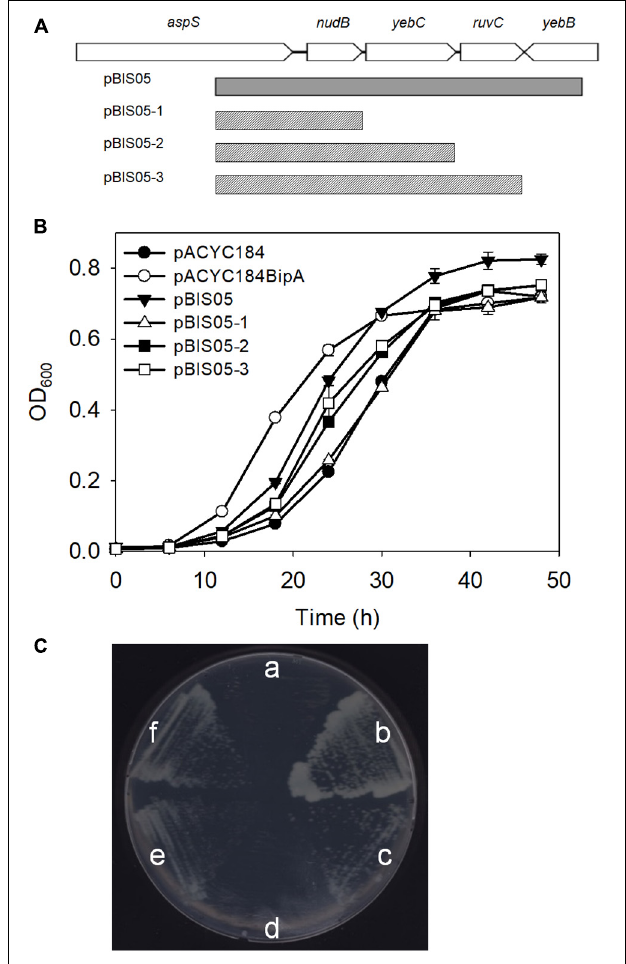
FIGURE 1 | Genomic library clone that suppresses cold-sensitive growth defects of the ESC19 strain at 20 ◦ C. (A) Schematic diagram of the genomic locus containing the suppressor gene. The gray square box represents the suppressor library clone. The scratched boxes represent the truncated clones constructed from pBIS05. (B , C) Recovered growth phenotype of the ESC19 strain caused by the isolated suppressor. ESC19 cells were transformed with each plasmid as presented above. Each transformant was incubated in LB medium containing chloramphenicol and kanamycin at 20 ◦ C. Cultures were diluted five times before measurement of the optical density at 600 nm. Experiments were performed in three independent replicates and error bars represent SD. Overnight cultures were diluted 100-fold with LB medium containing chloramphenicol and kanamycin. LB agar plates supplemented with same antibiotics were streaked with 2.5 µ l of diluted culture. (a) , pACYC184; (b) , pACYC184BipA; (c) , pBIS05; (d) , pBIS05-1; (e) , pBIS05-2; and (f) ,